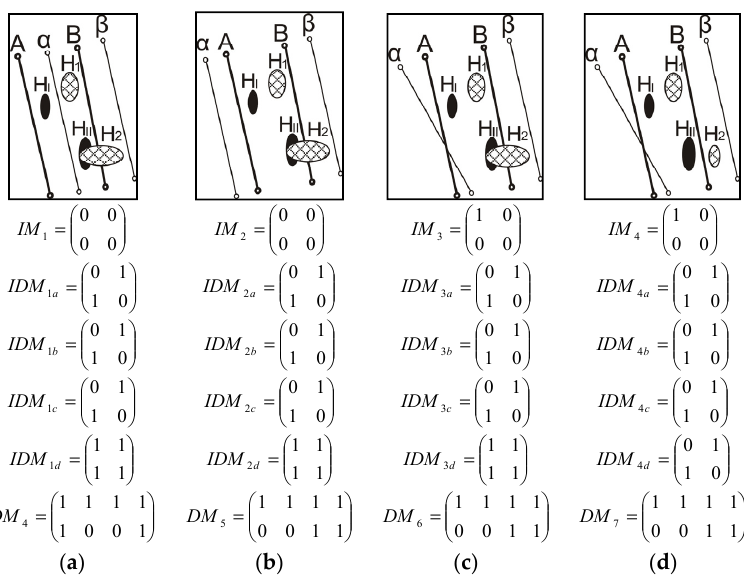
Figure 8. Four similar situations between two DSLMs. ( a ) The first situation; ( b ) the second situation; ( c ) the third situation; ( d ) the fourth situation.